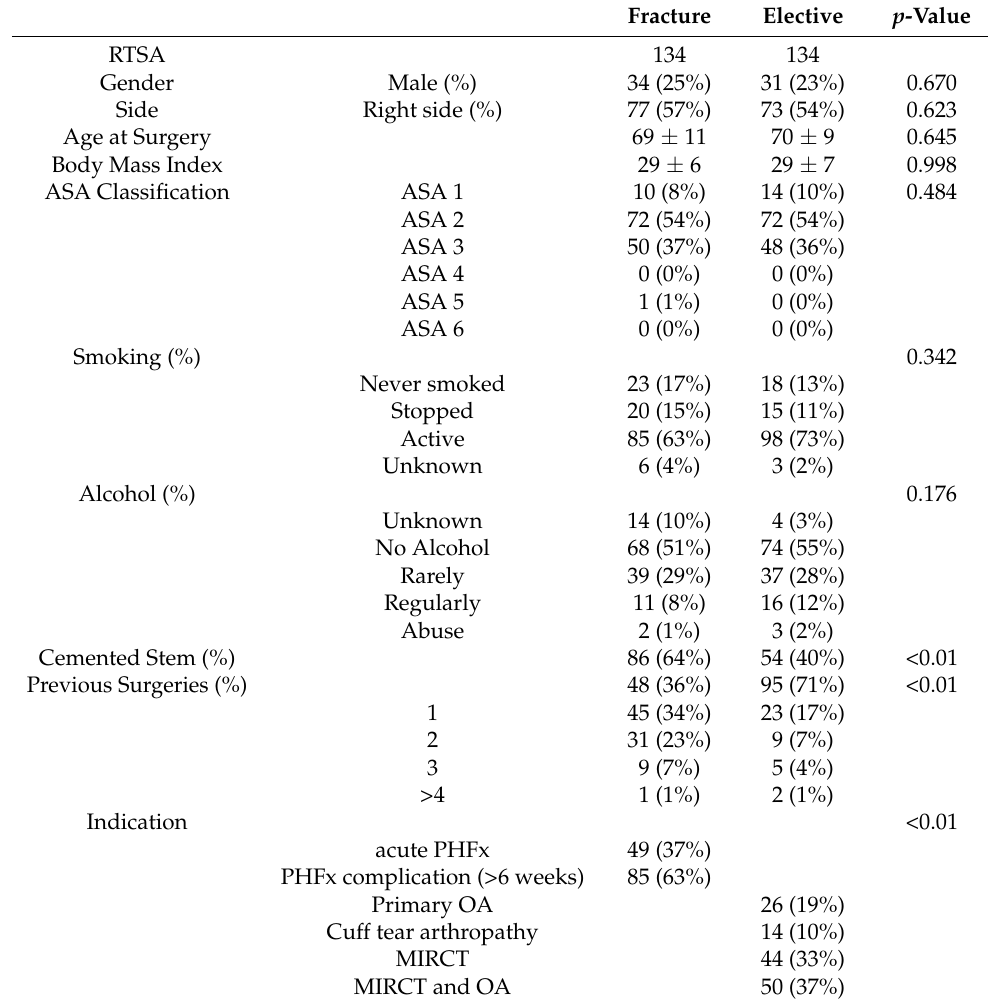
Table 1. Demographic